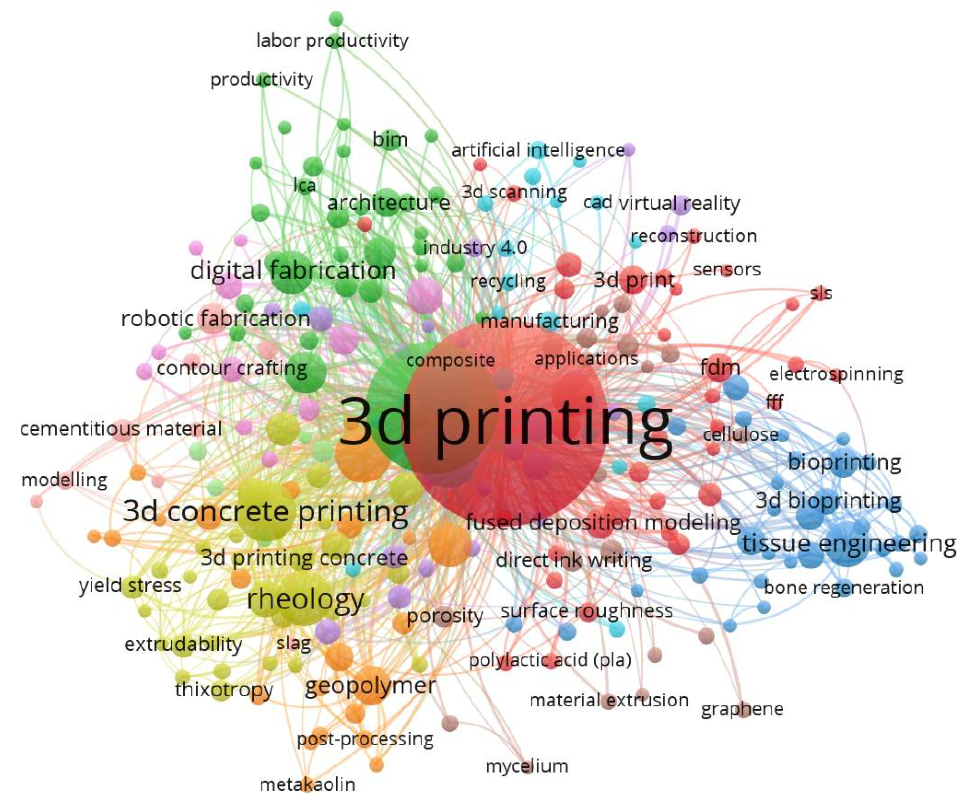
Figure 2. A demonstration of the keyword analysis conducted via VOSviewer software.